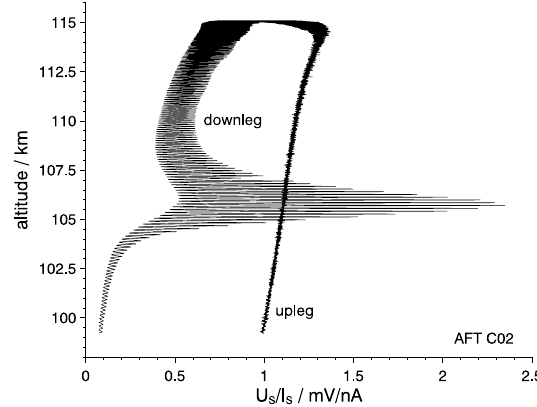
Figure 15. Ratio of voltage to current for an aft sensor during the downleg. Raw values including 2.9Hz modulation due to rocket